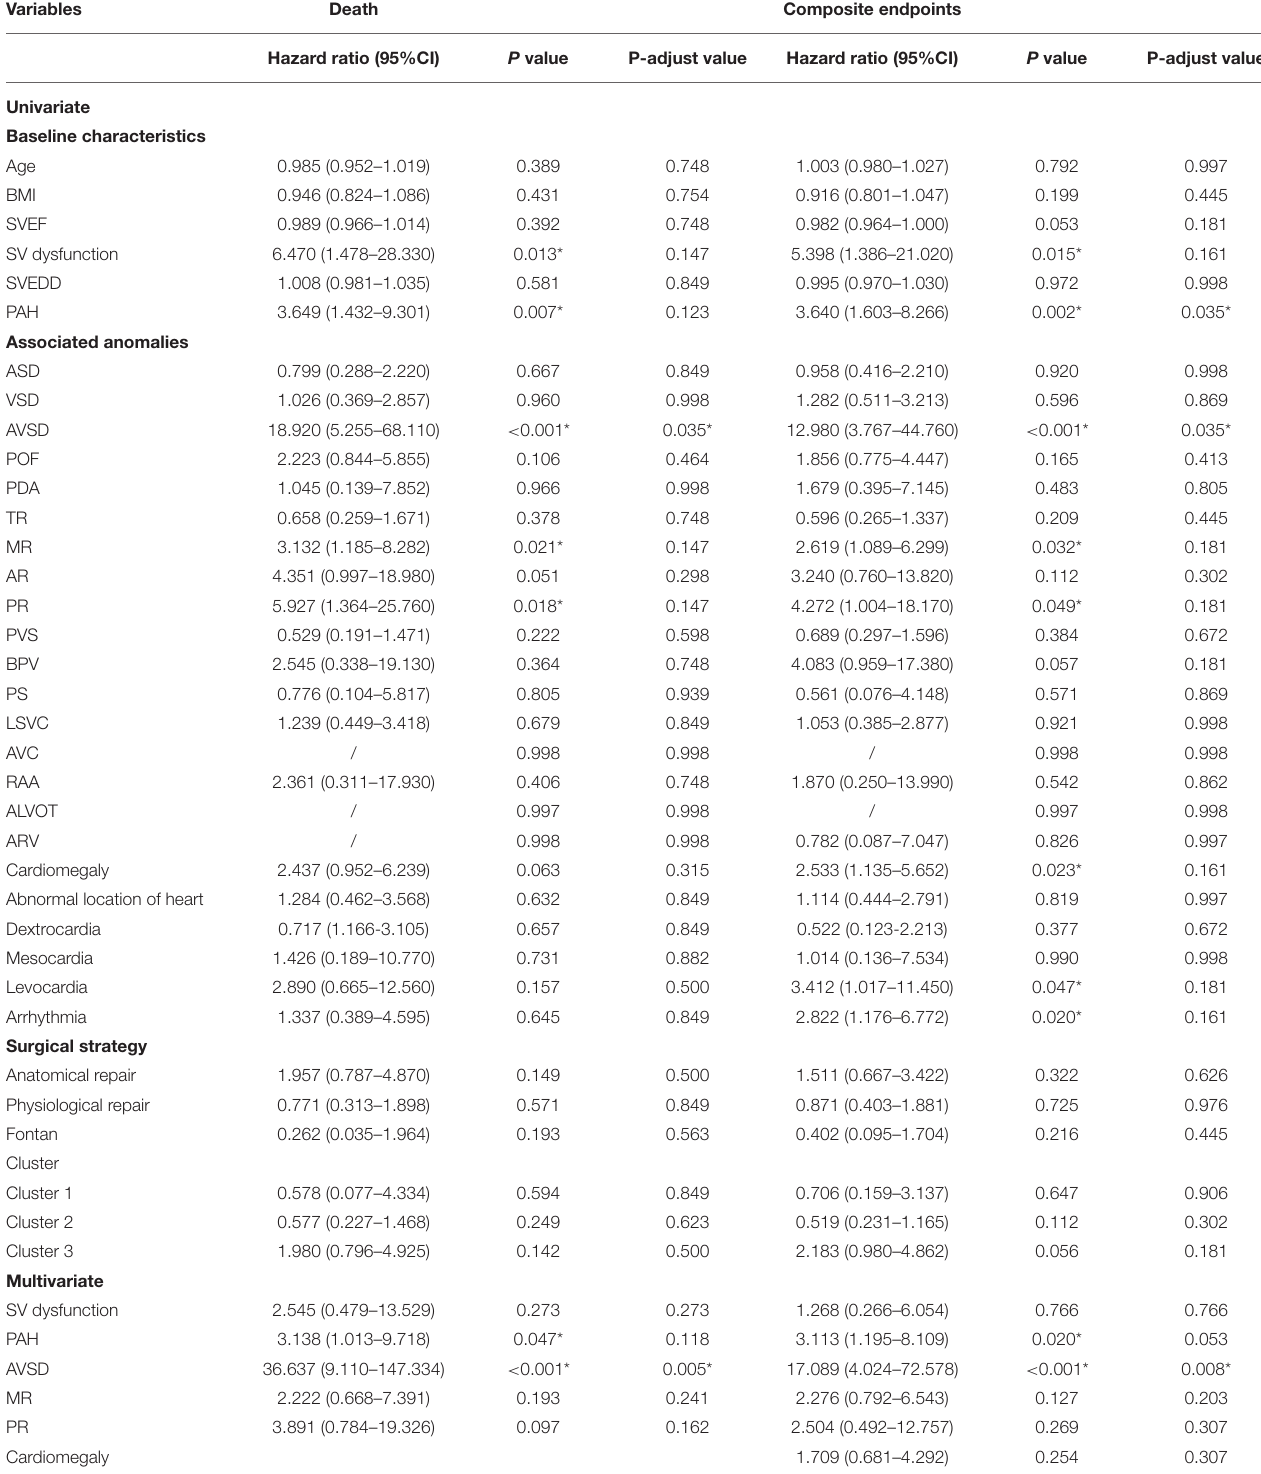
TABLE 2 | Univariable and multivariable analysis for